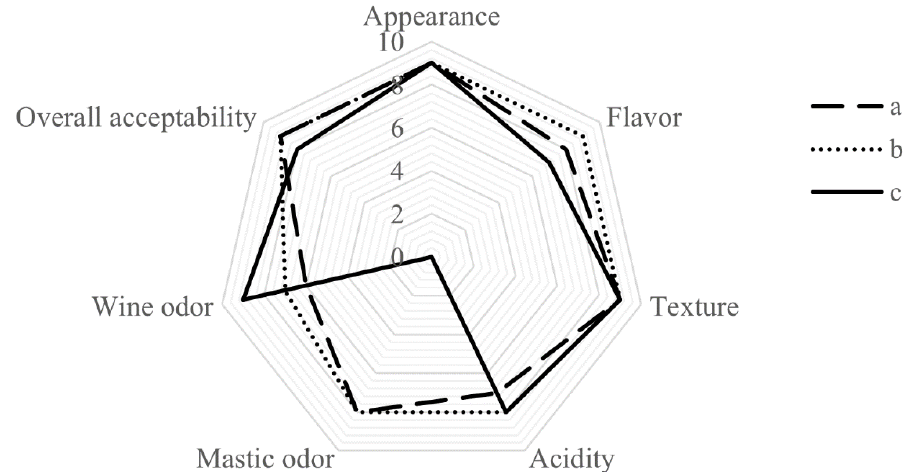
Figure 2. Sensory evaluation of wines produced by ( a ) immobilized cells on P. terebinthus resin at 14 ◦ C and storage at 22–28 ◦ C; ( b ) immobilized cells on P. terebinthus resin at 14 ◦ C and storage at 4 ◦ C; and ( c ) by free cells at 14 ◦ C and storage at 4 ◦ C at the 30th day of their storage.